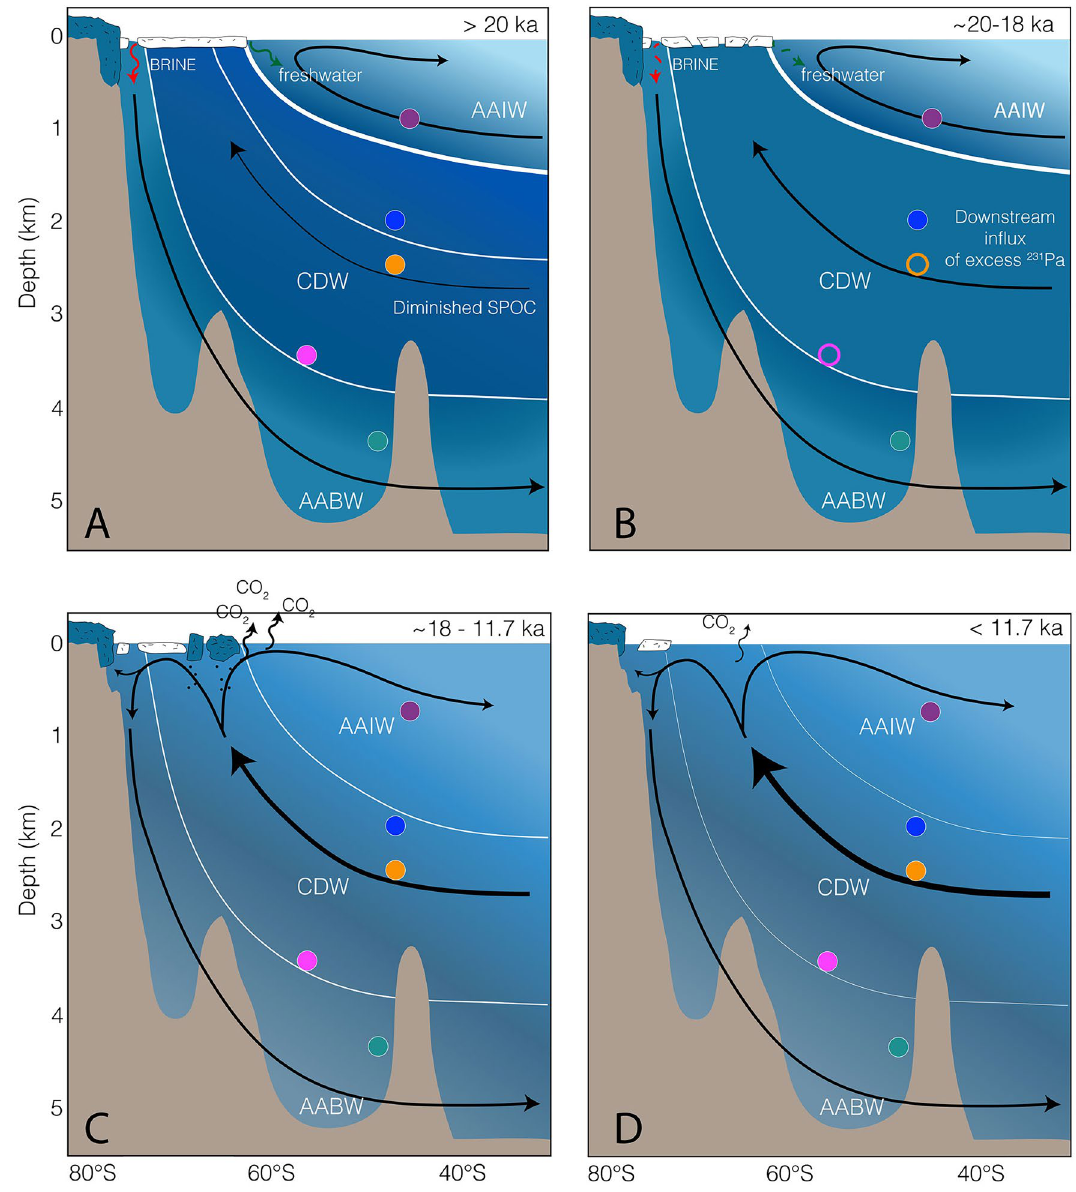
Figure 6. South Pacific overturning and ventilation. ( A ) Last Glacial. Diminished SPOC with separated deep- and intermediate-water cells. SO213-76-2 (green dot) under the influence of LCDW and AABW ( B ) LGM. Increasing SPOC transports excess 231 Pa downstream toward the CDW core-locations. ( C ) Deglacial Transition. Progressive increase in SPOC results in the release of CO 2 and the transport of warm deep-waters onto the shelf regions. Influx of excess 231 Pa from the upstream regions diminishes. Disintegration of ice-shelves and release of Iceberg Rafted Debris (black dots). ( D ) Holocene pattern of the SPOC. Colored dots—sediment records as shown in Fig. 2. Empty circles—no data in this time slice. White lines—assumed isopycnals, the thicker the lines, the stronger the vertical stratification. Black arrows—water mass circulation, thickness of the central arrow indicates relative SPOC strength. Color shading of the CDW-cell indicates its ventilation state according to Ronge et al. (2016). Dark blue—high CO 2 , low ΔΔ 14